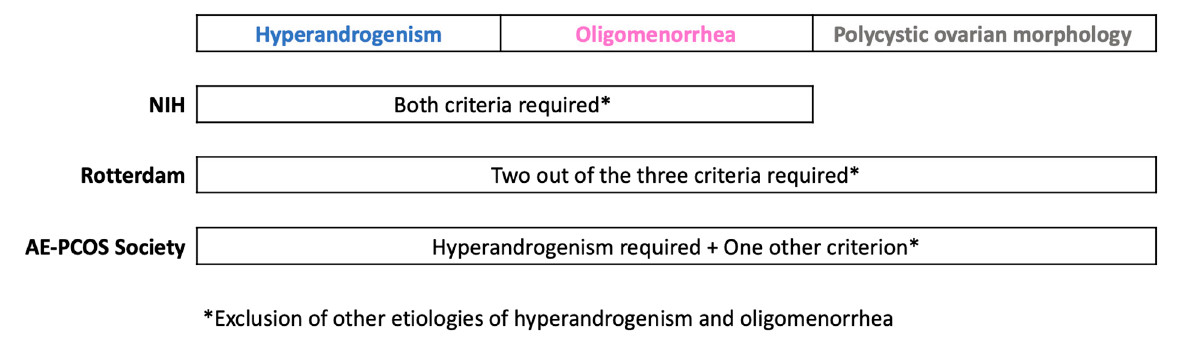
Figure 1. Current diagnostic criteria for